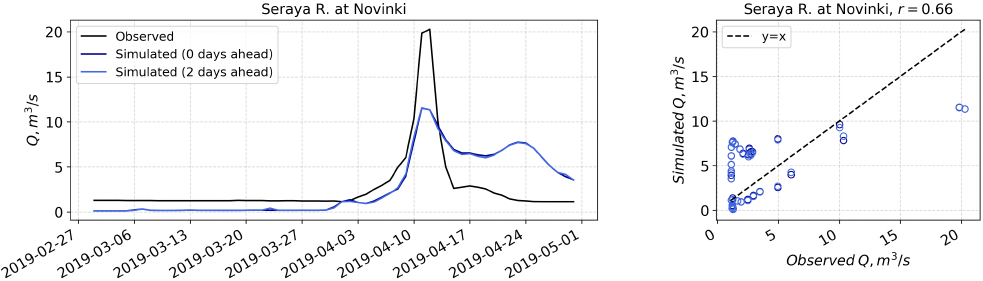
Figure 6. Hydrographs ( left plot ) and scatter plot ( right plot ) of observed and simulated discharges for Seraya R. at Novinki during the 2019th spring